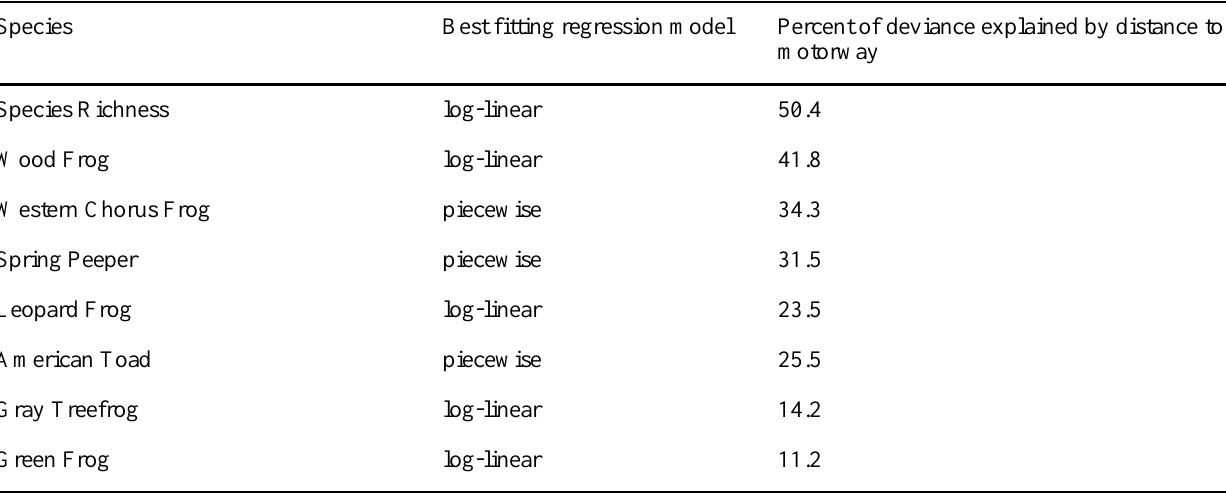
Table 2. Percentage of deviance explained by distance to the motorway (2006 data). The best-fitting model was determined by comparing the AICc values of the simple linear regression, log-linear regression (distance to Highway 401 was log-transformed) and piecewise regression models (Table 3) for each species and for species